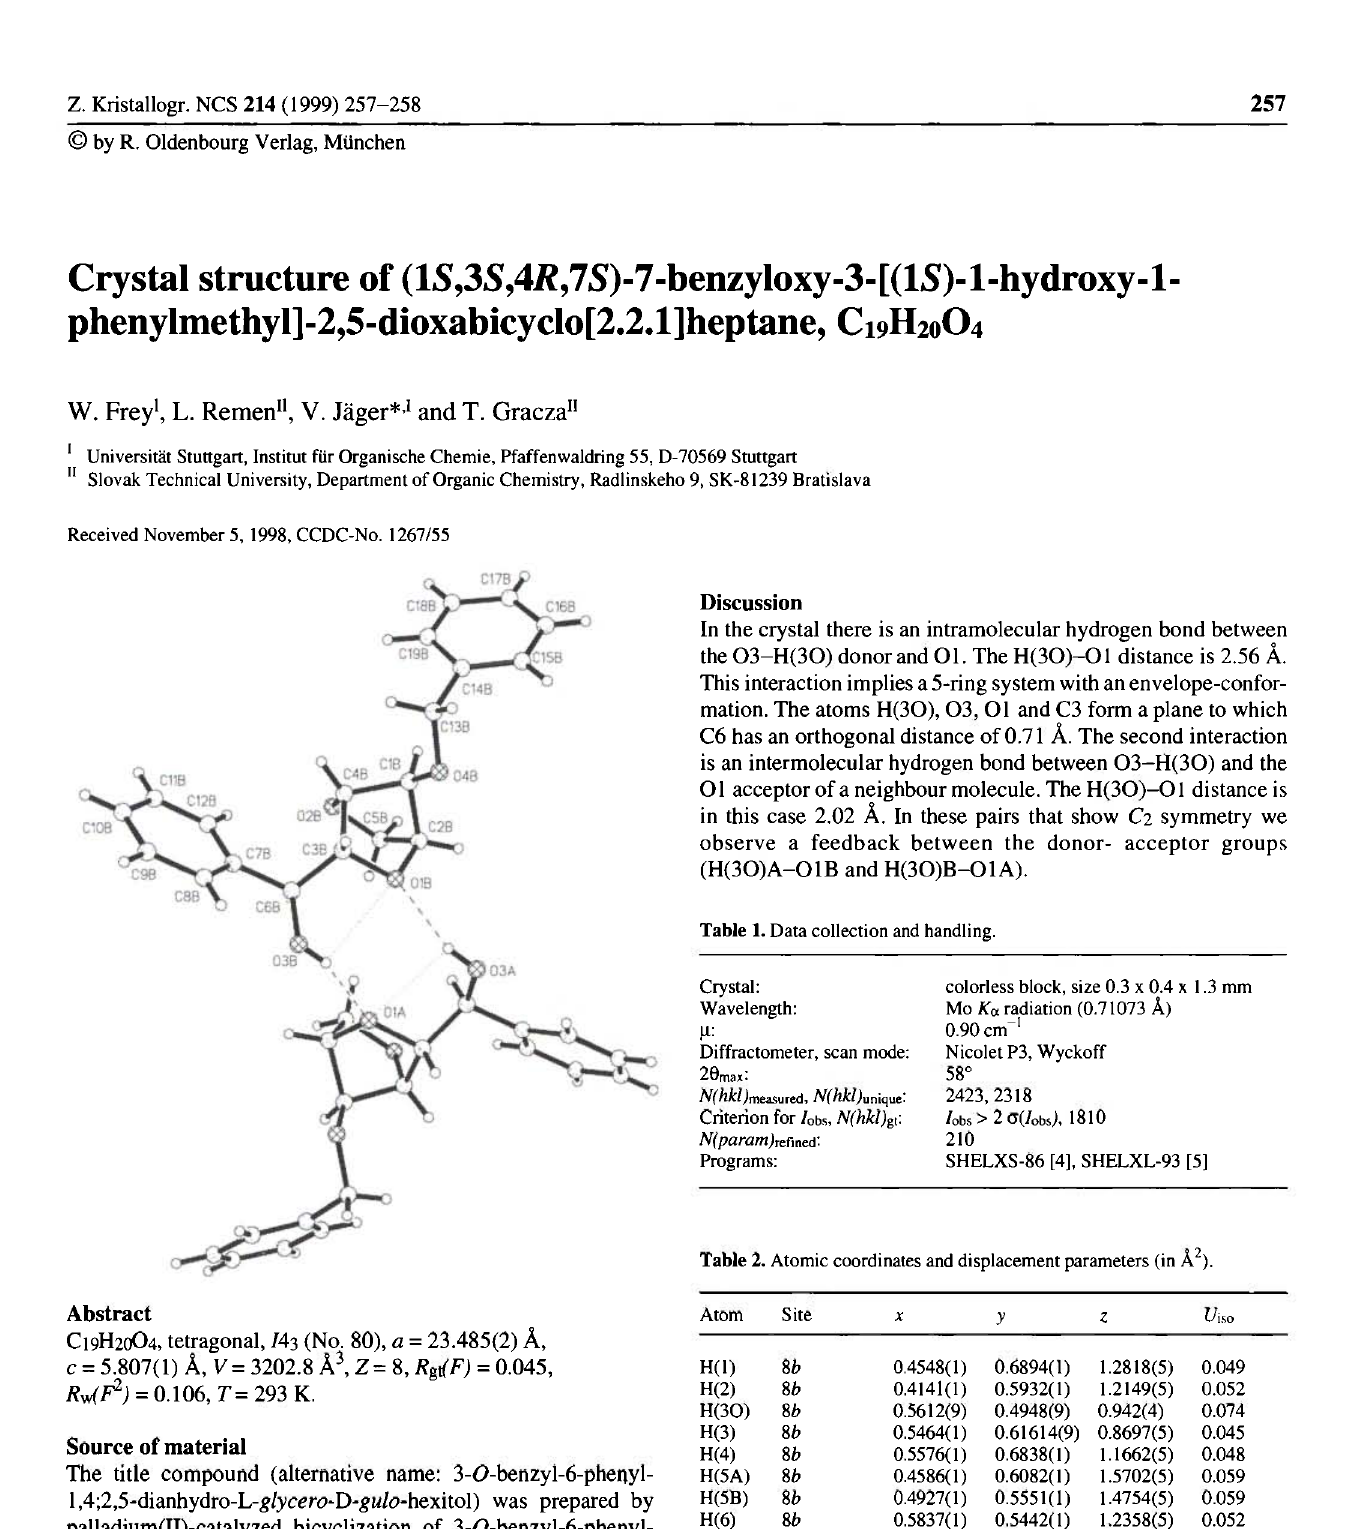
Table 2. Atomic coordinates and displacement parameters (in Ä 2